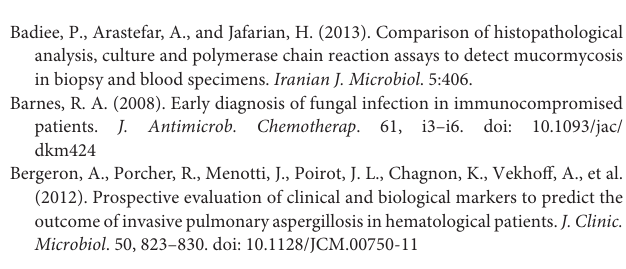
Supplementary Table 1 | Fungi used to check the specificity of new qPCR assay. Supplementary Table 2 | Accession numbers of sequences downloaded from the GenBank and strains used for the validation of technique. Supplementary Table 3 | Categorization of cases as per EORTC/MSGERC guidelines. Supplementary Table 4 | Demographic details of suspected IA patients. Supplementary Table 5 | Demographic and clinical characteristics of suspected IM patients. Supplementary Table 6 | Repeatability and reproducibility of qPCR assay for different molds. Supplementary Table 7 | Detailed description of co-infection